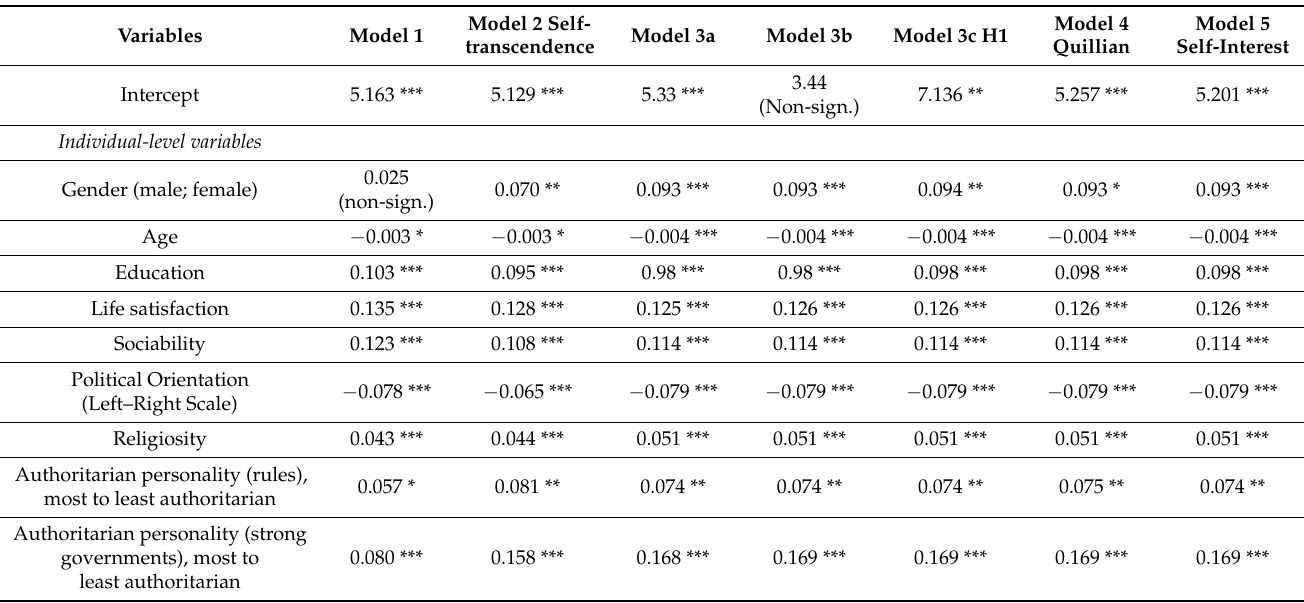
Table 2. Coefficients of fixed effects (a) per model tested in the multilevel analysis of attitudes towards